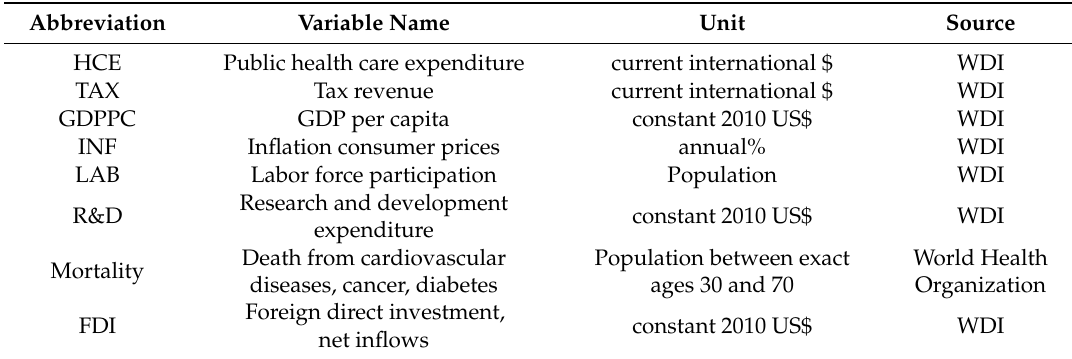
Table 1. Data sources and